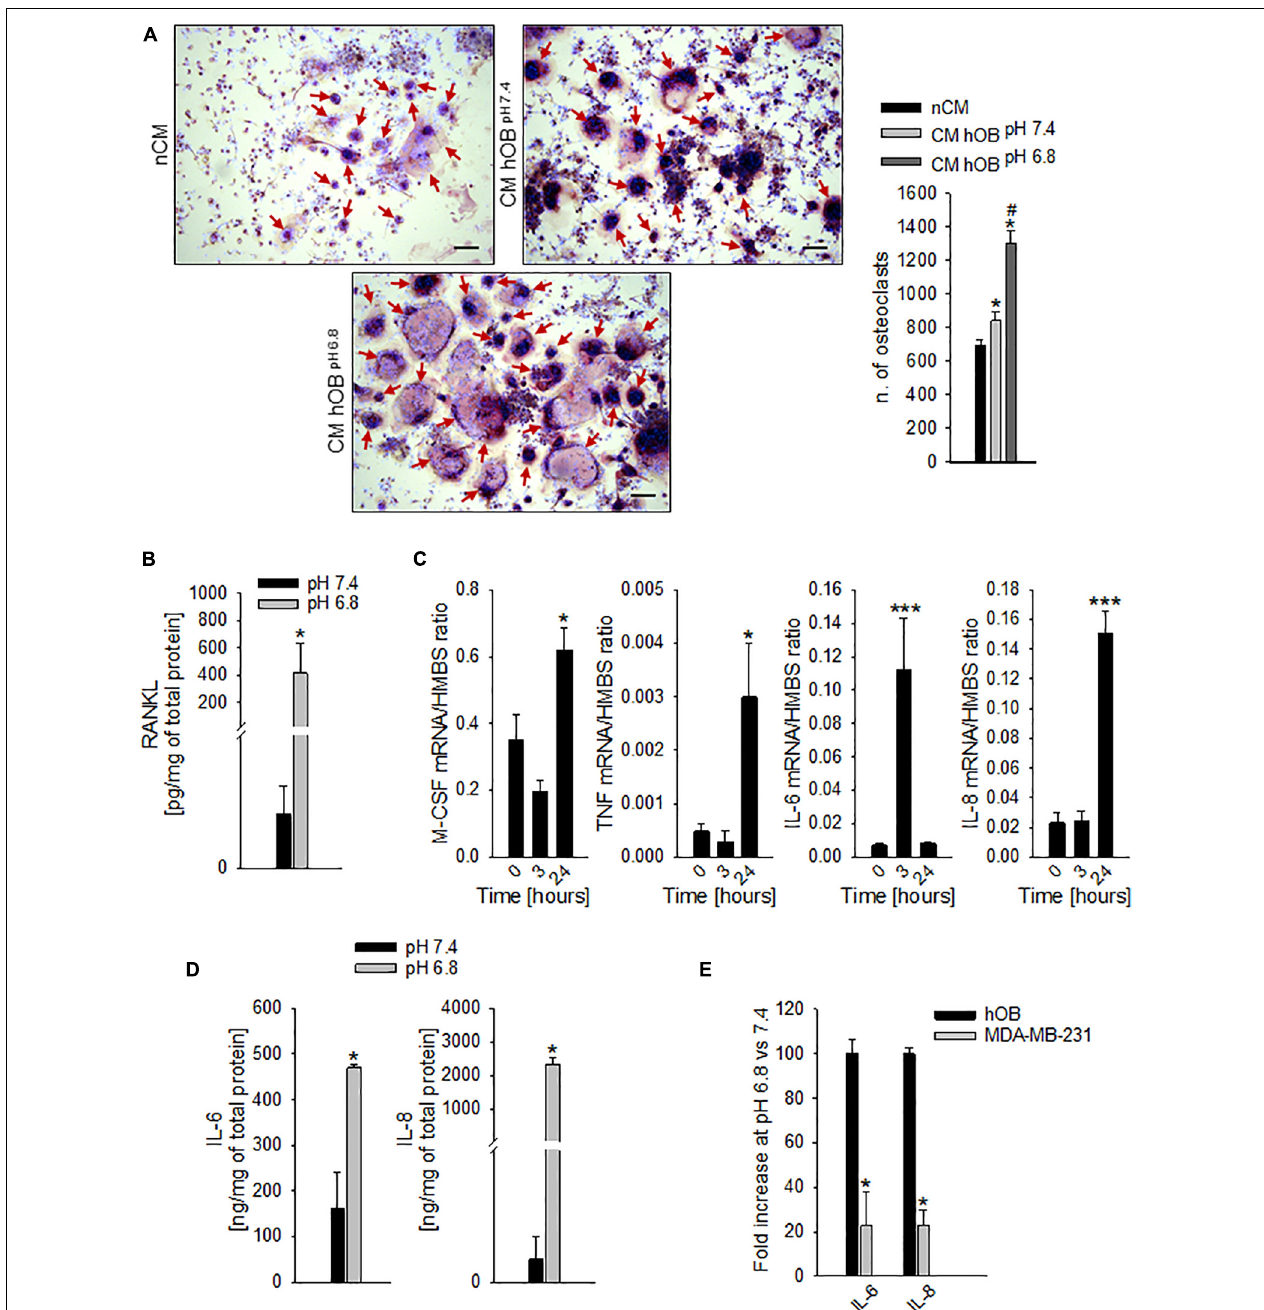
FIGURE 5 | Extracellular acidosis promotes the secretion of pro-osteoclastogenic mediators from osteoblasts (OB). (A) On the right, graph of N. of TRACP+ and multinucleated OC obtained from PBMC, after 7 days of incubation with the CM hOB pH 6 · 8 , or the CM hOB pH 7 · 4 . The non-conditioned medium (nCM) was used as negative control. Mean ± SEM ( n = 4, * p < 0.05 vs. nCM; # p < 0.05 vs. CM hOB pH 7 · 4 ). On the left, representative images; scale bar 100 µ m (red arrows show multinucleated TRACP + OC). (B) Levels of secreted free RANKL protein as detected by specific ELISA in hOB supernatant after incubation with acid or neutral medium. Mean ± SEM ( n = 4, * p < 0.05). (C) Increase over the time of mRNA expression levels of M-CSF, TNF- α (TNF), IL-6, and IL-8 in hOB cultures, after the exposure to extracellular acidosis. Mean ± SEM ( n = 4, * p < 0.05 and *** p < 0.001 vs. Time 0). (D) Protein levels of IL-6 and IL-8 by ELISA in hOB supernatant after incubation with acid or neutral medium (pH 6.8 and 7.4, respectively). Mean ± SEM ( n = 4, * p < 0.05). (E) mRNA expression of IL-6 and IL-8 in MDA-MB-231 cells with respect to hOB exposed for 3 h to pH 6.8 (= K, 100%).